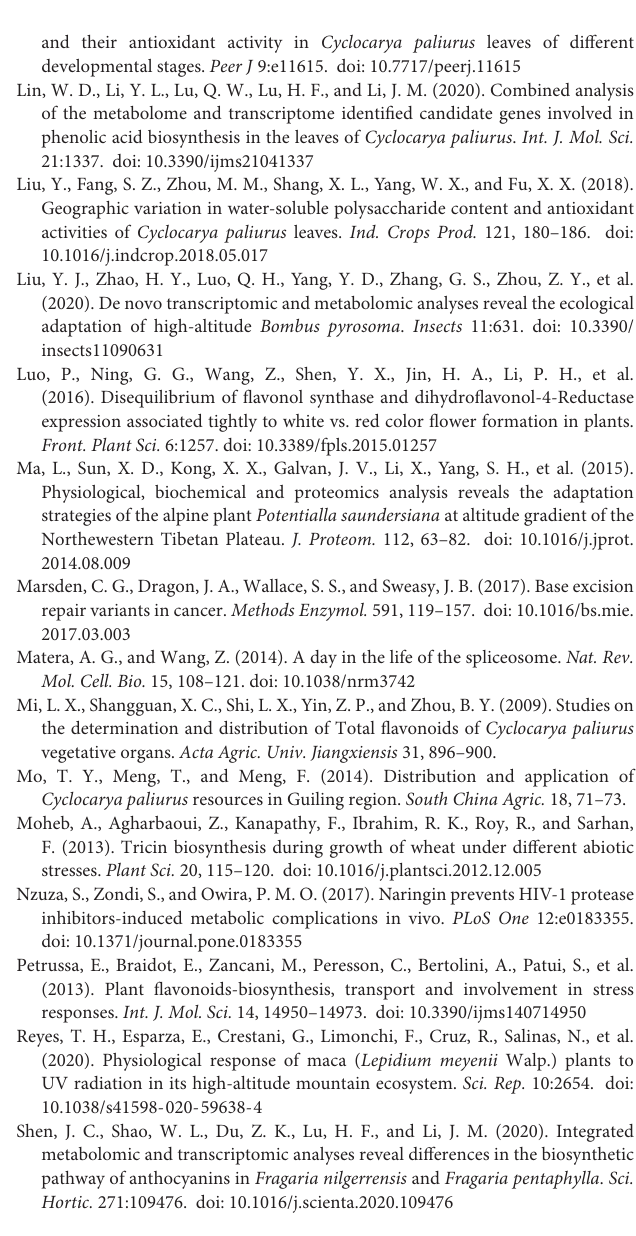
Supplementary Figure 2 | KEGG pathway terms assignment of 91 up-regulated genes in the leaves of Cyclocarya paliurus at high altitude than at low altitude. Supplementary Figure 3 | KEGG pathway terms assignment of 641 down-regulated genes in the leaves of Cyclocarya paliurus at high altitude than at low